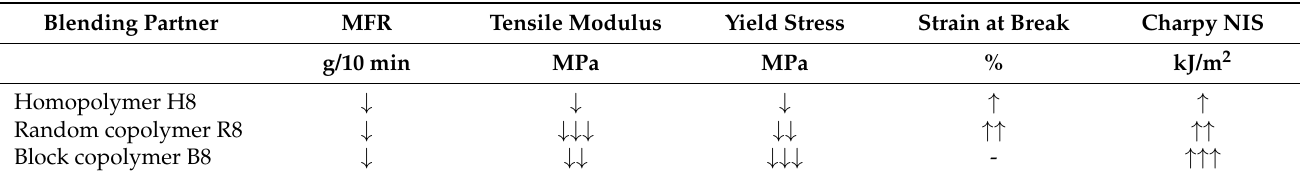
Table 9. Influence of PP type on the overall property profile for blending with a high MFR homopoly- mer (direction of arrows indicate increasing or decreasing values and number of arrows indicate the extent of the